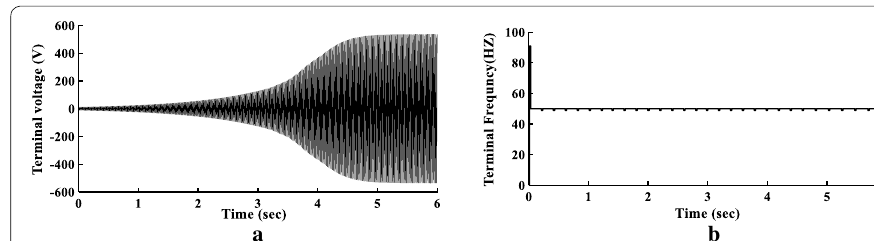
Fig. 9 No-load building up process a terminal voltage, b terminal frequency